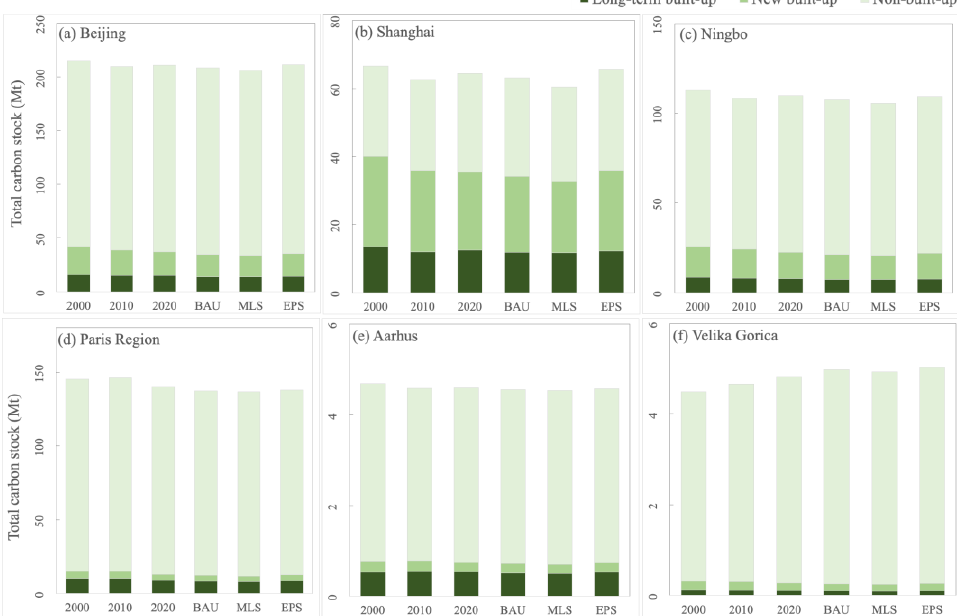
Figure A5. Total carbon stock statistics for different urban development phases of six cities from 2000 to 2030.